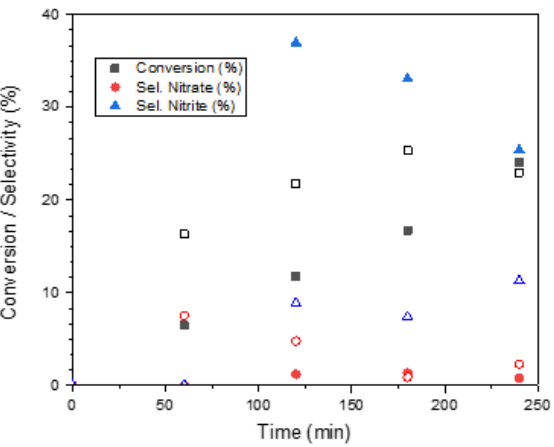
Figure 2. Time dependence of conversion and selectivity. Full symbols = sample P25, hollow symbols sample FSP.